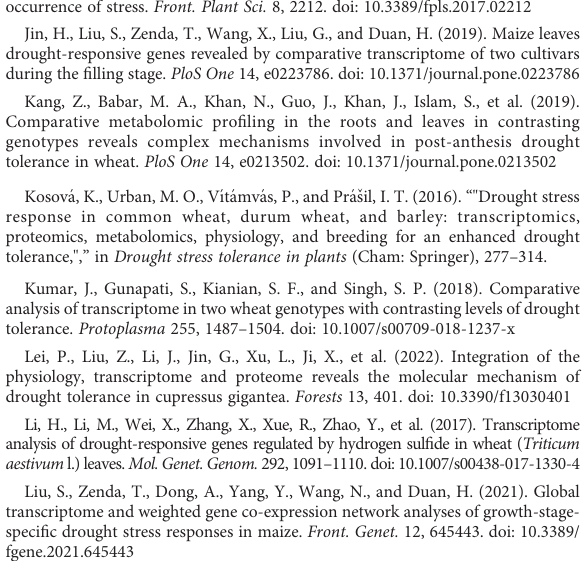
SUPPLEMENTARY FIGURE 2 Principal Component Analysis(PCA) shows resultsusing ascatteredgraph with 54.46% variance on the x-axis and 14.29% on the y-axis.